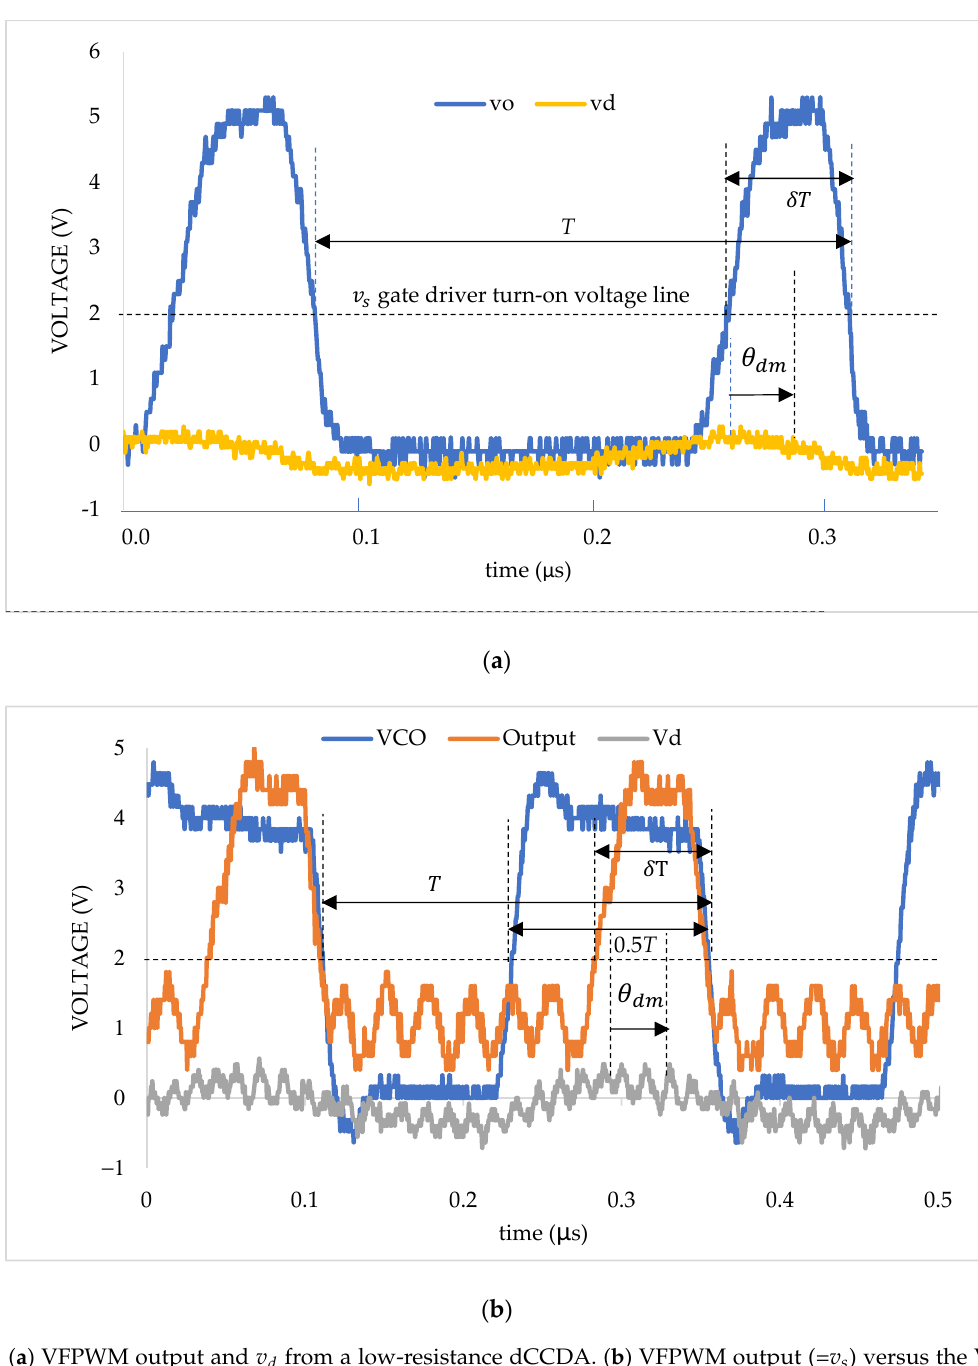
tances, 𝐶 (cid:3030)(cid:3040)(cid:2878) and 𝐶 (cid:3030)(cid:3040)(cid:2879) , respectively, according to the two ± terminals of the amplifier in Figure 9. The selection of 𝐶 (cid:3030)(cid:3040)(cid:2878) and 𝐶 (cid:3030)(cid:3040)(cid:2879) could be many combinations. Figure 18 shows the results for 𝐶 (cid:3030)(cid:3040)(cid:2879) = 15𝑝𝐹 , and 𝐶 (cid:3030)(cid:3040)(cid:2878) varies from 9 to 23 pF when R = 20 k Ω and α = 1 .